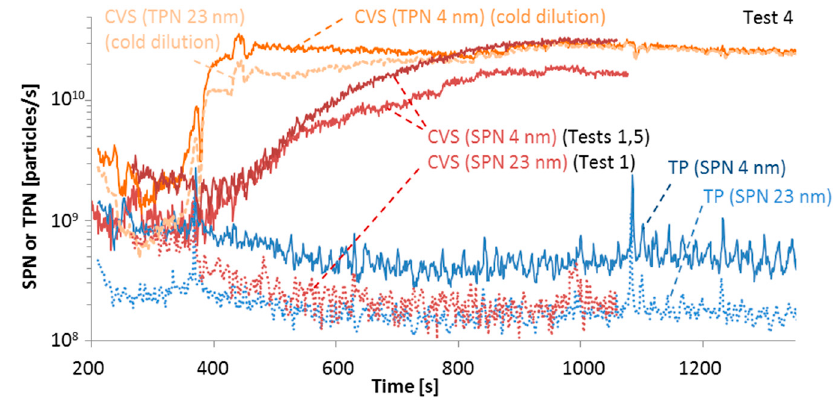
Figure 3. Total particle number (TPN) at the dilution tunnel (CVS) (orange lines, test 4) and solid particle number (SPN) at the tailpipe (TP) (blue lines, test 4) and the CVS (red lines, tests 1 and 5).